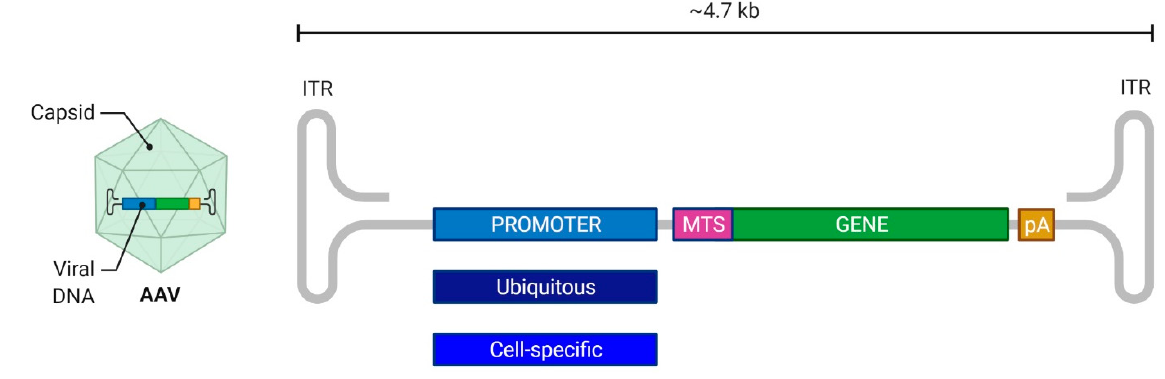
Figure 2. Schematic representation of “Adeno-Associated Virus (AAV) Genome”. Retrieved from https://app.biorender.com/biorender-templates (accessed on 16 April 2022).